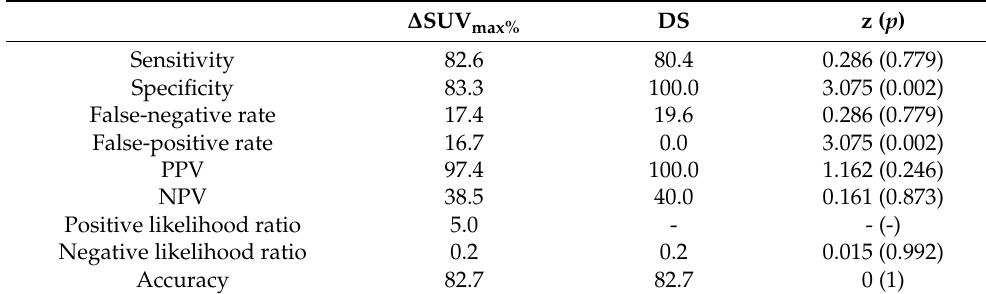
Table 4. Comparison of ∆ SUV max% and DS performance levels at interim PET-CT in predicting a therapy response at 24 months. Values are expressed as percentages. ∆ SUV max%